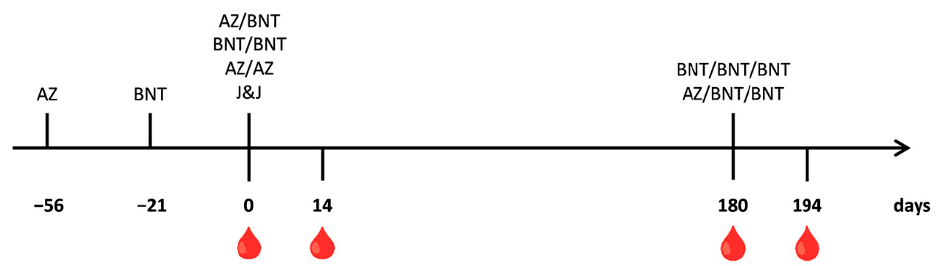
Figure 1. Schematic presentation of the SARS-CoV-2 vaccinations and blood sampling time points. Blood sampling is indicated by a blood drop. Vaccinations are shown as letters. The time point 0 of the J&J vaccination corresponds to naïve sera and was used to determine the background levels of the